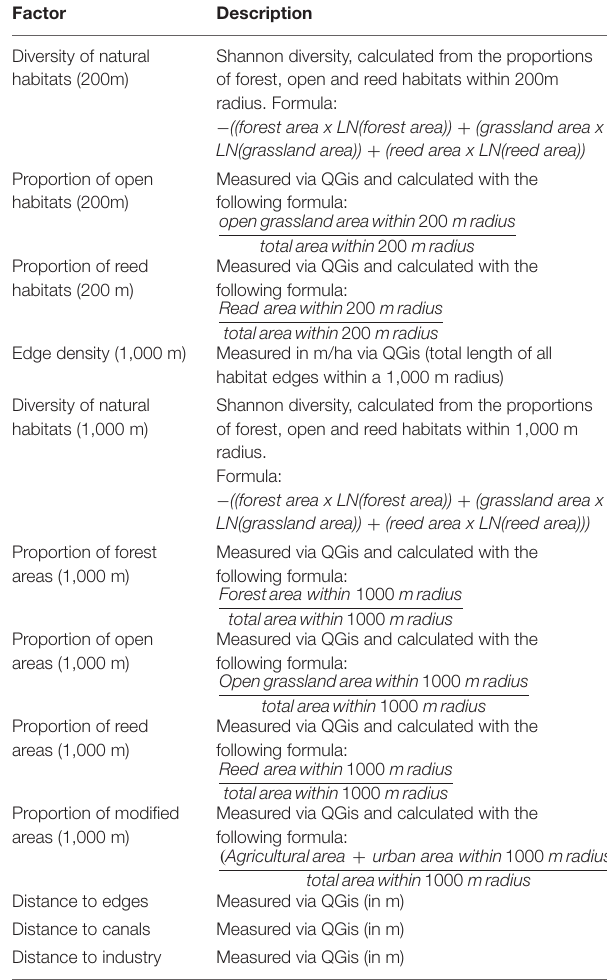
TABLE 1 | (Local) Habitat quality factors. TABLE 2 | (Landscape-scale) Habitat quantity